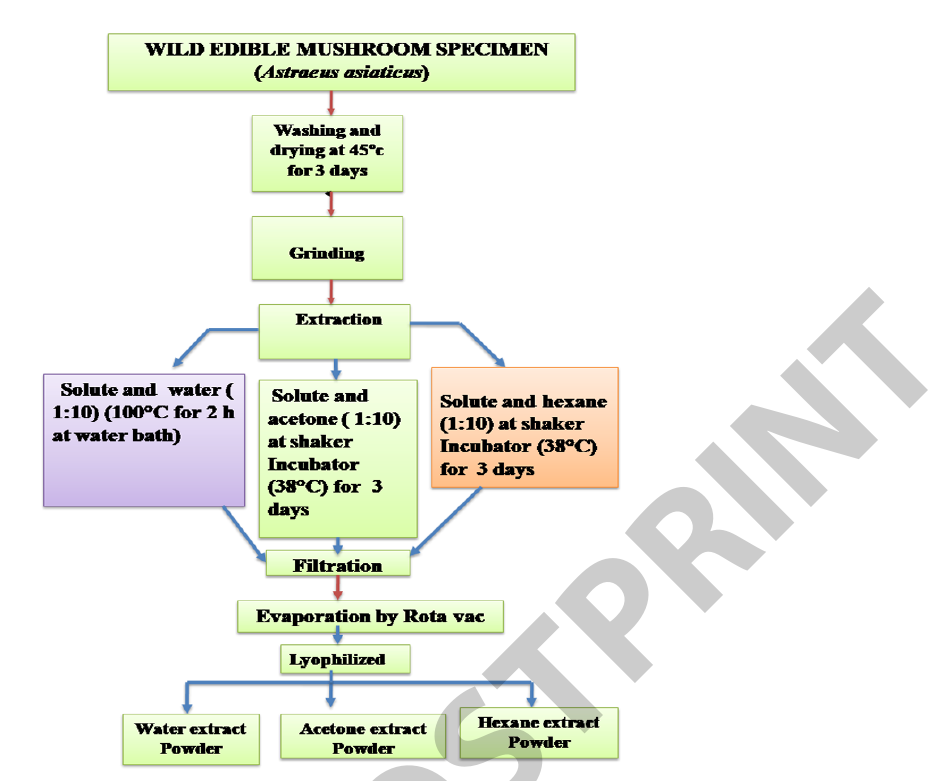
Figure 1 Design of the mushroom fruitbody extraction process in different solvent